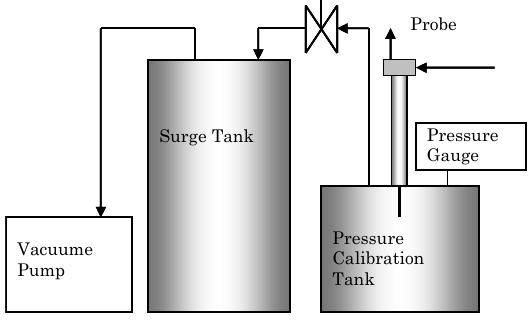
Fig. 4 Sensitivity calibration